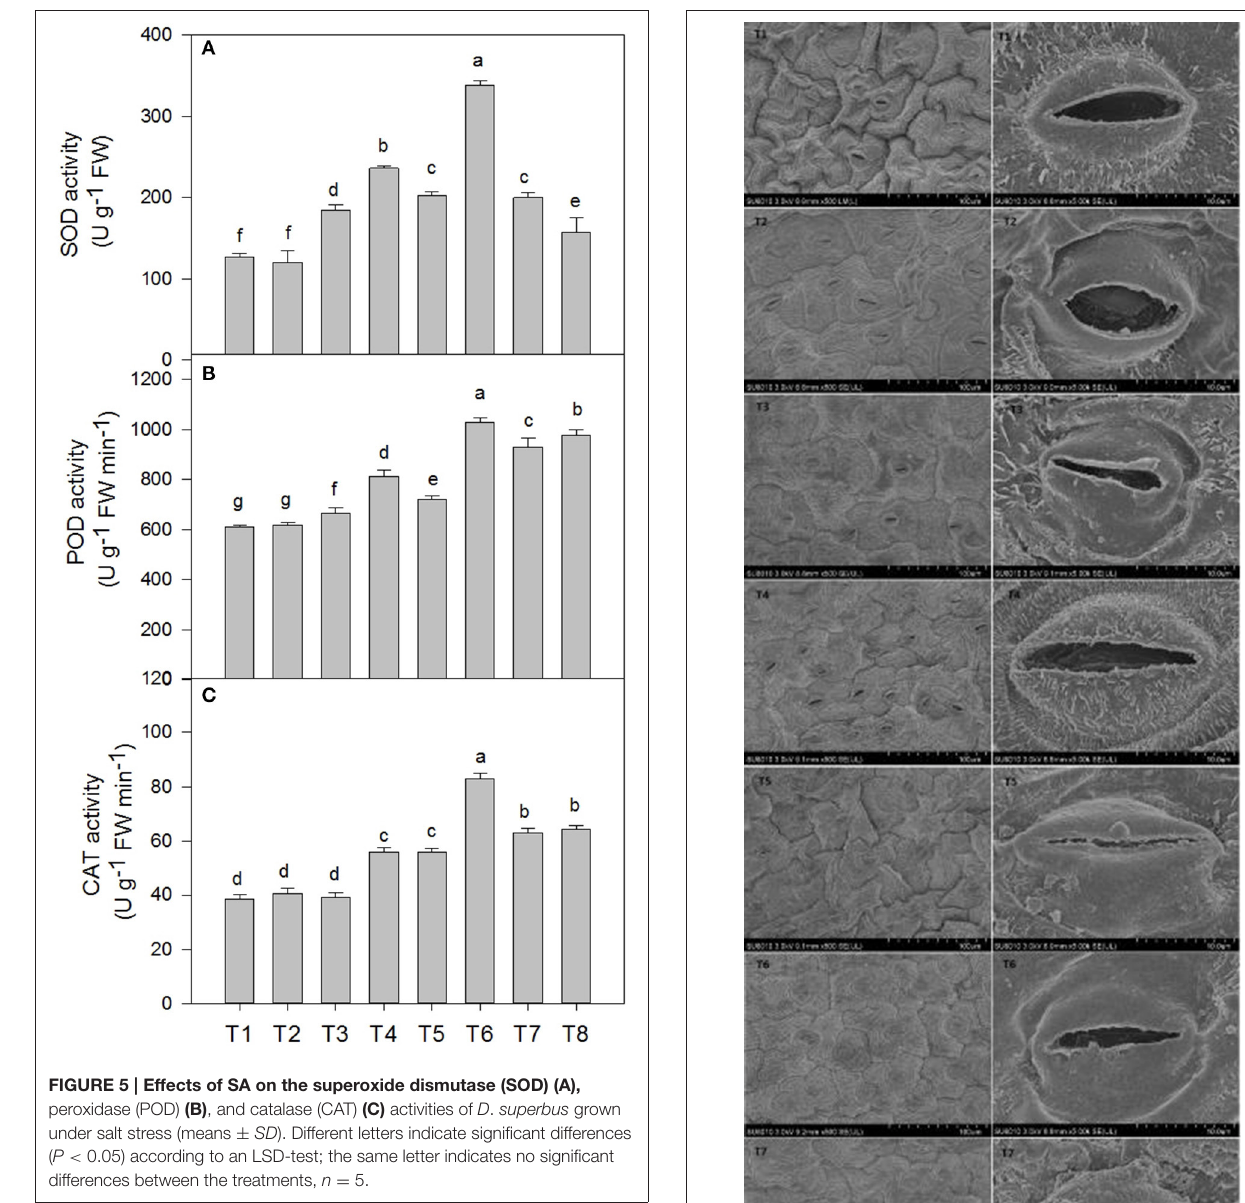
Frontiers in Plant Science |